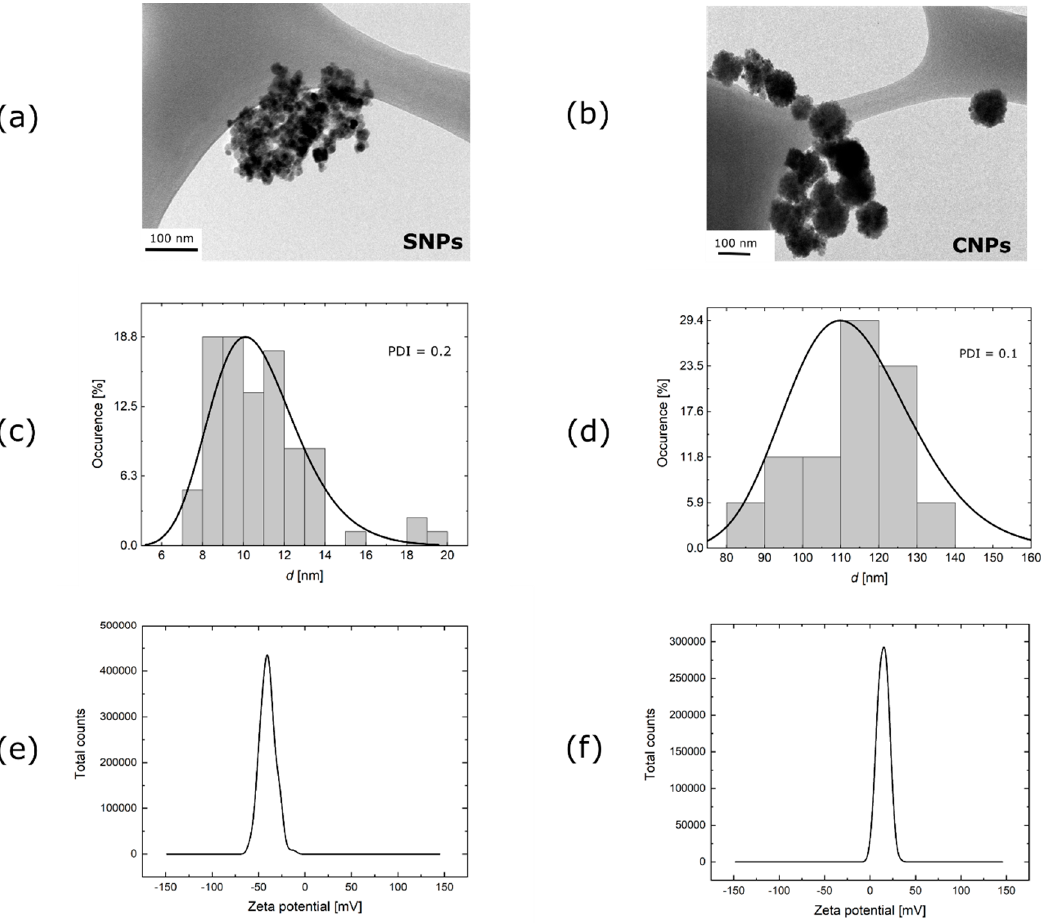
Figure 1. The characterization of nanoparticles: transmission electron microscopy (TEM) micrograph for ( a ) single nanoparticles (SNPs), ( b ) cluster nanoparticles (CNPs). Particle size distribution from TEM with calculated polydispersity index (PDI) for ( c ) SNPs and ( d ) CNPs. Zeta potential of ( e ) SNP water suspension and ( f ) CNP water suspension.